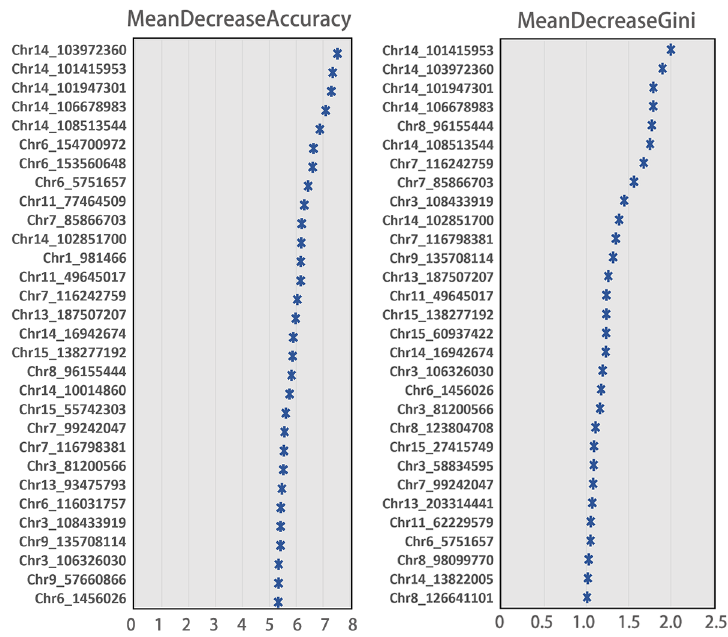
Figure 3. Top 30 important SNPs with the highest scores in random forest analysis. The X-axis represents the scores from the MDA or MDG measures and each row on the Y-axis represents an SNP, labeled by the chromosome and physical location.